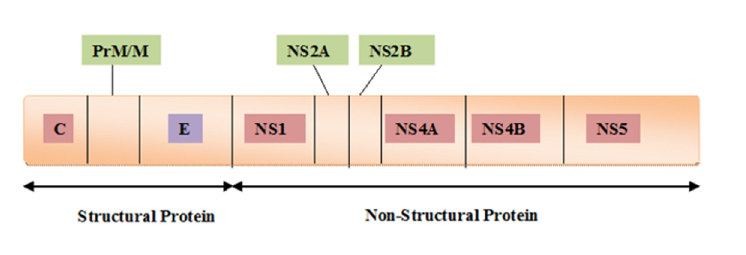
Fig 1. Shows dengue virus